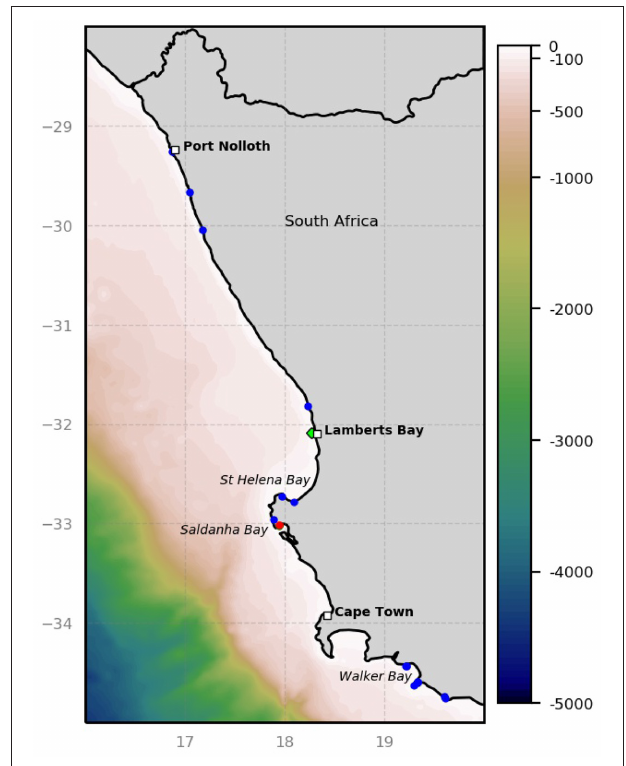
FIGURE 1 | Map showing the west coast aquaculture facilities, with important bays and towns for reference. The location of the sampling station off Lamberts Bay is indicated by a green diamond. Abalone farms are shown as blue dots and mussel farms are shown in red (adapted from DAFF, 2017).